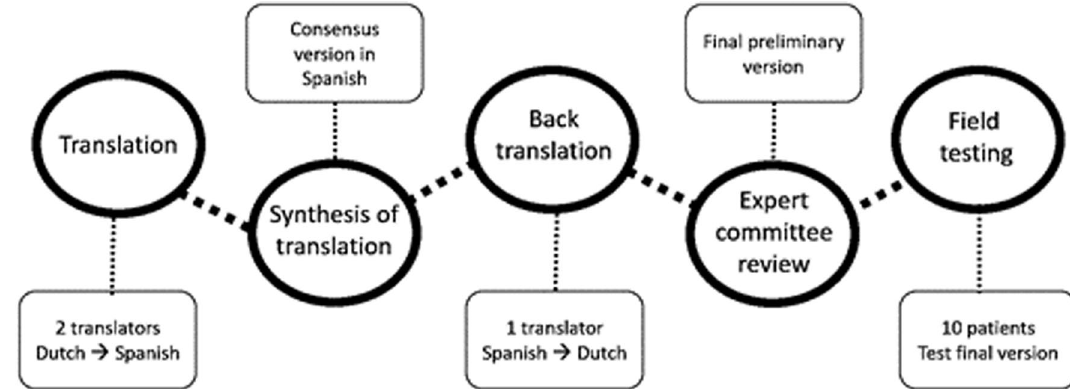
Fig. 1 General Coping with rheumatic stressors (CORS) translation and cross‑cultural adaptation workflow and